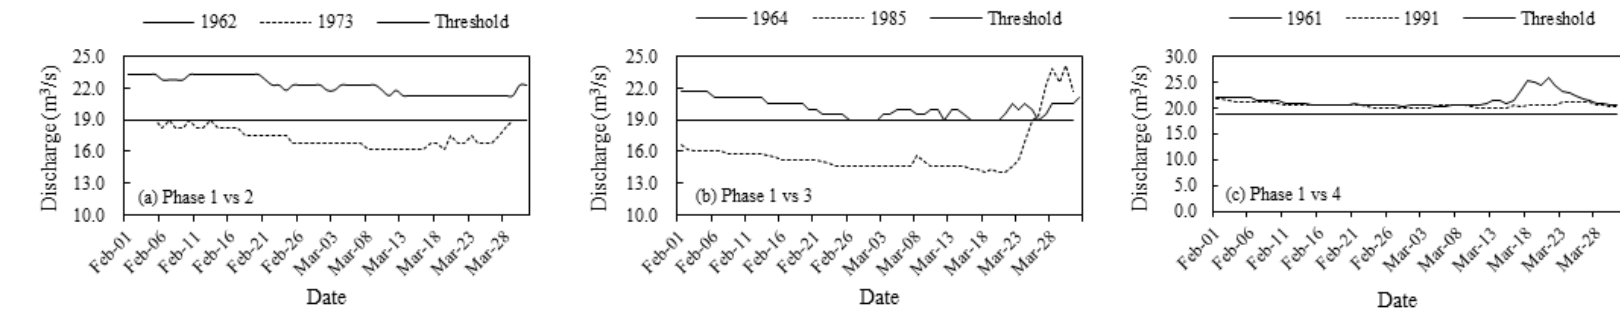
Figure 12. Examples of the duration of low flows in paired years during the forest harvesting period: ( a ) Phase 1 vs. 2; ( b ) Phase 1 vs. 3 and ( c ) Phase 1 vs. 4 (duration for other selected pairs can be found in Appendix A).